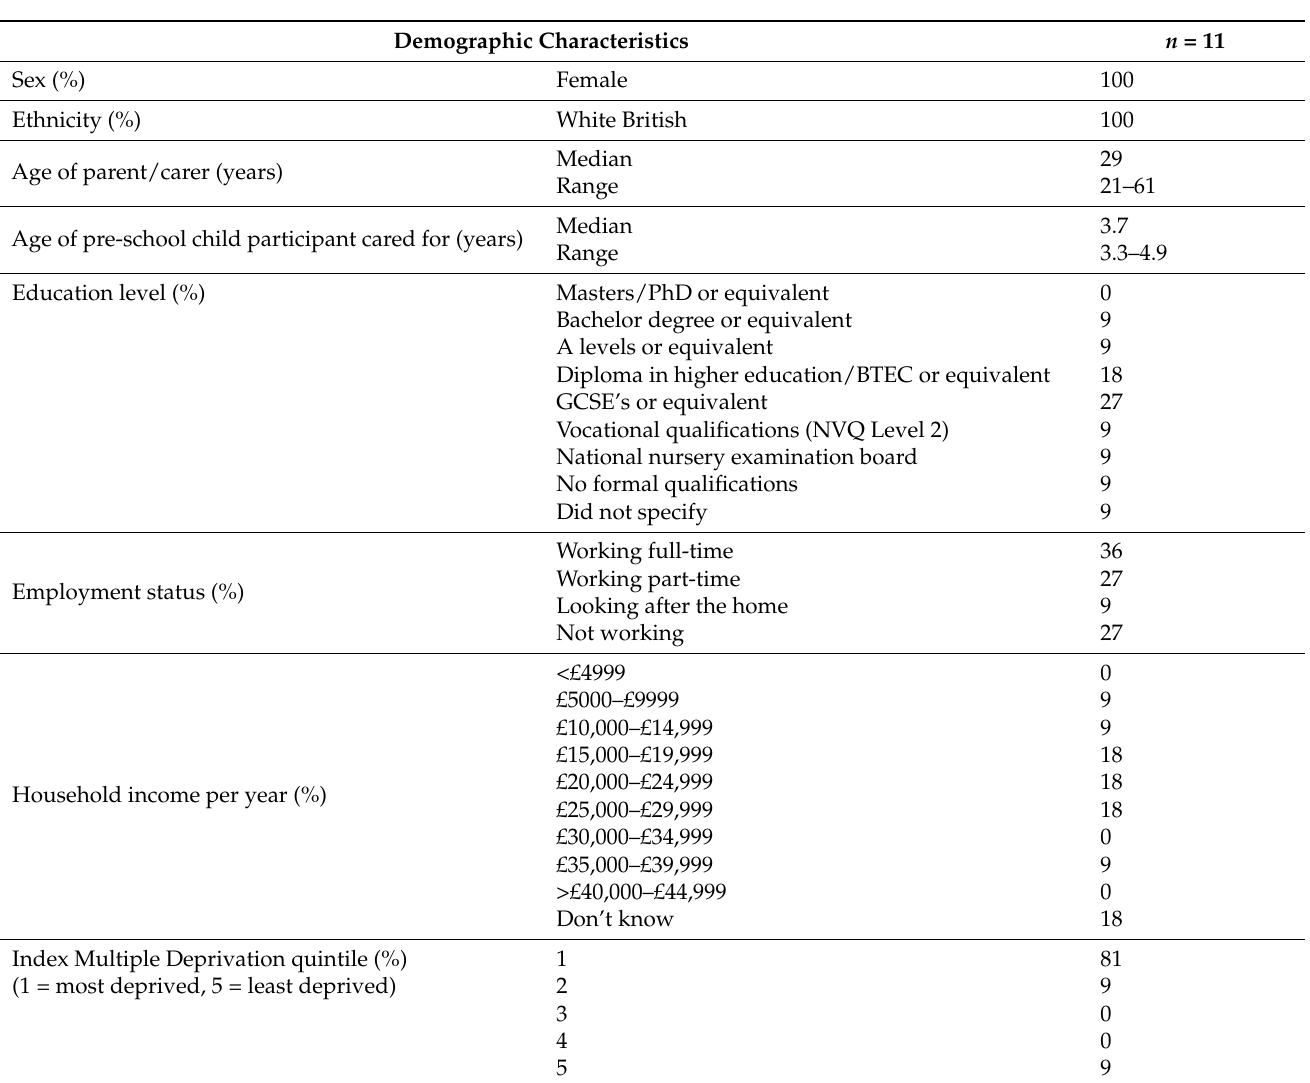
Table 1. Demographic characteristics of